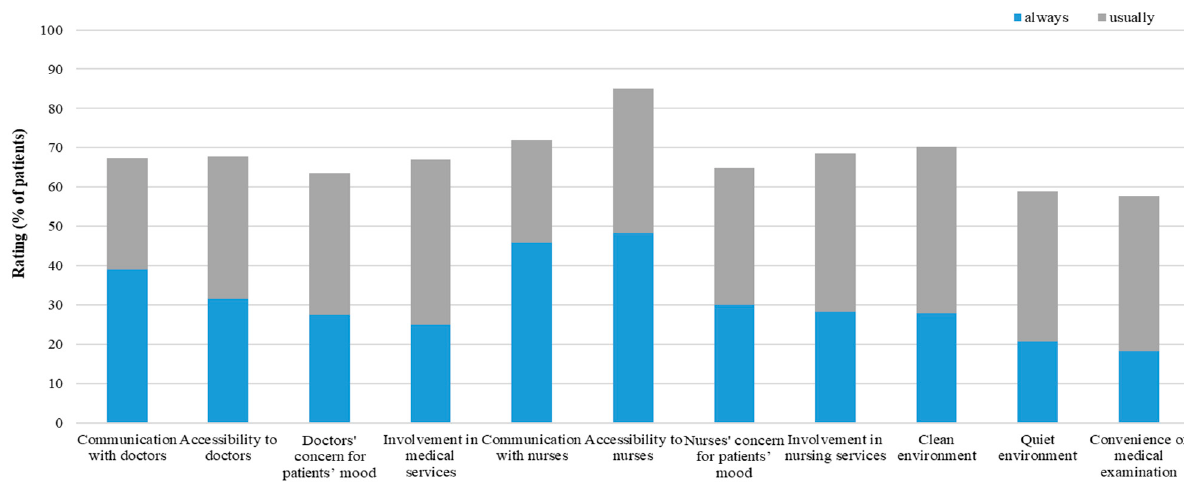
Figure 1. Percentage of patients’ perceptions of hospital care.